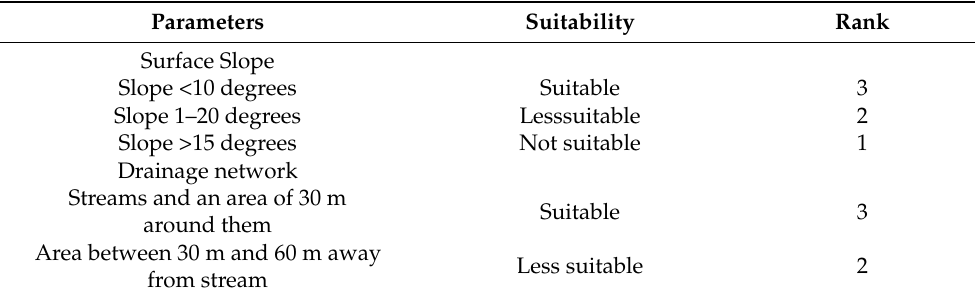
Table 2. Categorization and ranking for selecting suitable sites for check dams; parameters of surface slope, drainage network, settlements, roads, runoff volume, and rainwater sites results are shown with their suitability and ranks rationally set based on IMSD (1995), INCOH (1995), and FAO